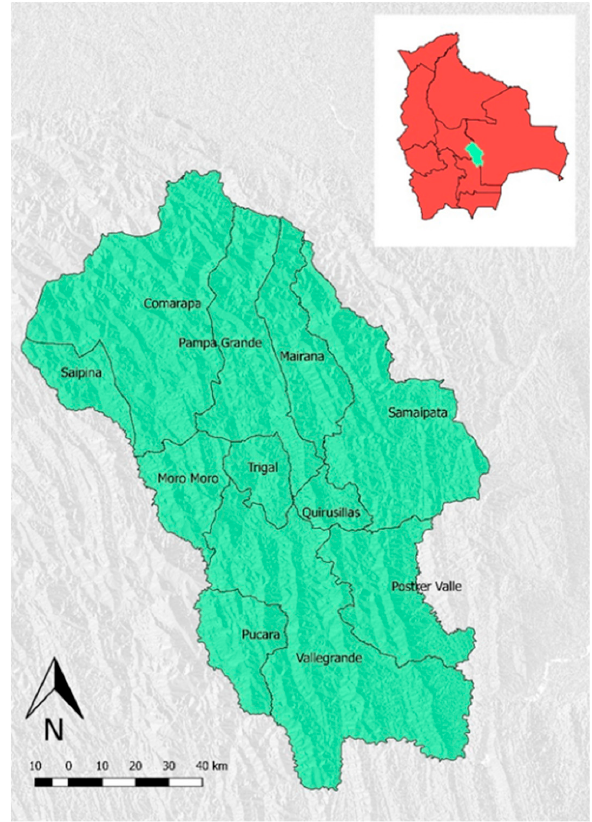
Figure 1. Study area and municipalities of “Valles Cruceños”, Santa Cruz department, Bolivia.